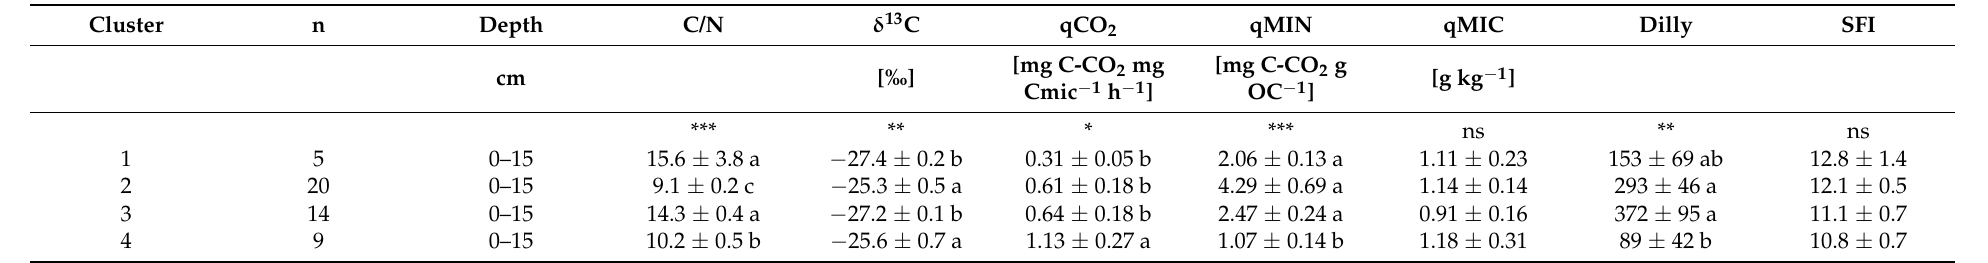
Table 4. Means ± standard errors of several indicators of each cluster at a depth of 0–15 cm (based on organic matter fractionation), with the Kruskal–Wallis significance presented as letters and symbols. C/N—carbon to nitrogen ratio; δ 13C—carbon isotopic ratio; qCO 2 —metabolic quotient; qMIN—mineralization quotient; qMIC—microbial quotient; Dilly—Dilly’s index; SFI—soil biofertility index. Within each column, means with different letters indicate significant differences. * p -value < 0.05; ** p -value < 0.01; *** p -value < 0.001; ns—not significant. Cluster